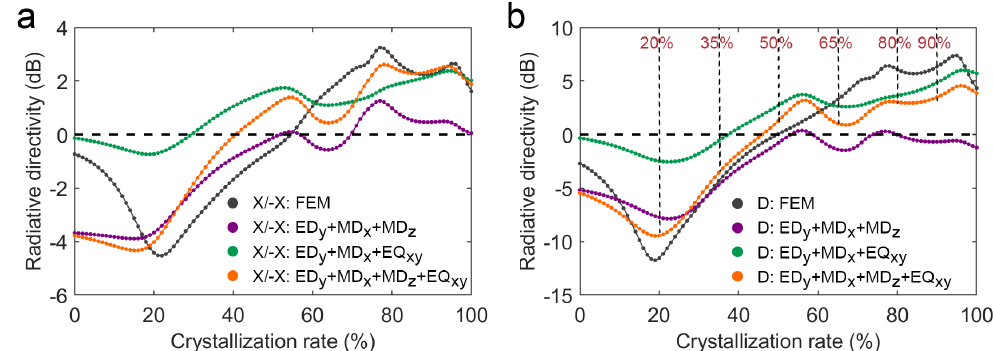
Figure 6. Directivities of the FEM results and interference far-field radiation patterns according to the complex coefficients of major multipole moments at 3.6 µ m wavelength: ( a ) X/–X directivity as a function of crystallinity; ( b ) D directivity as a function of